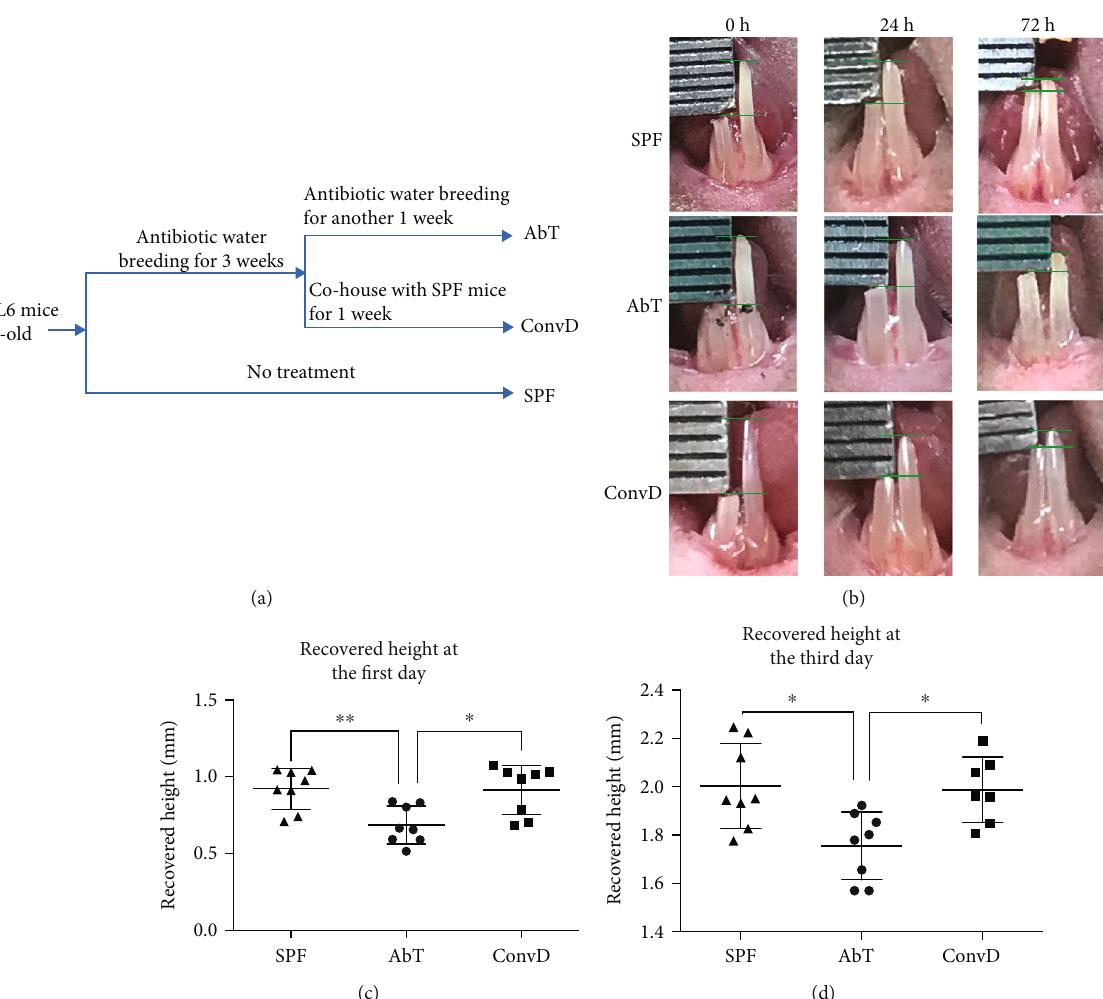
Figure 1: Antibiotic treatment decreased the growth rate of mouse incisors. (a) Experimental procedure schematic. (b) Representative images of height di ff erence of bilateral incisors at di ff erent time points after mechanical injury. (c) Histogram of statistical analysis of recovered height of incisors at a 24-hour time point. (d) Histogram of statistical analysis of recovered height of incisors at a 72-hour time point. Error bars represent the SEM from the mean values. ∗∗ P < 0 : 001 ; ∗ P < 0 : 05 . AbT: antibiotic treated; ConvD: conventionalized; SPF: speci fi c